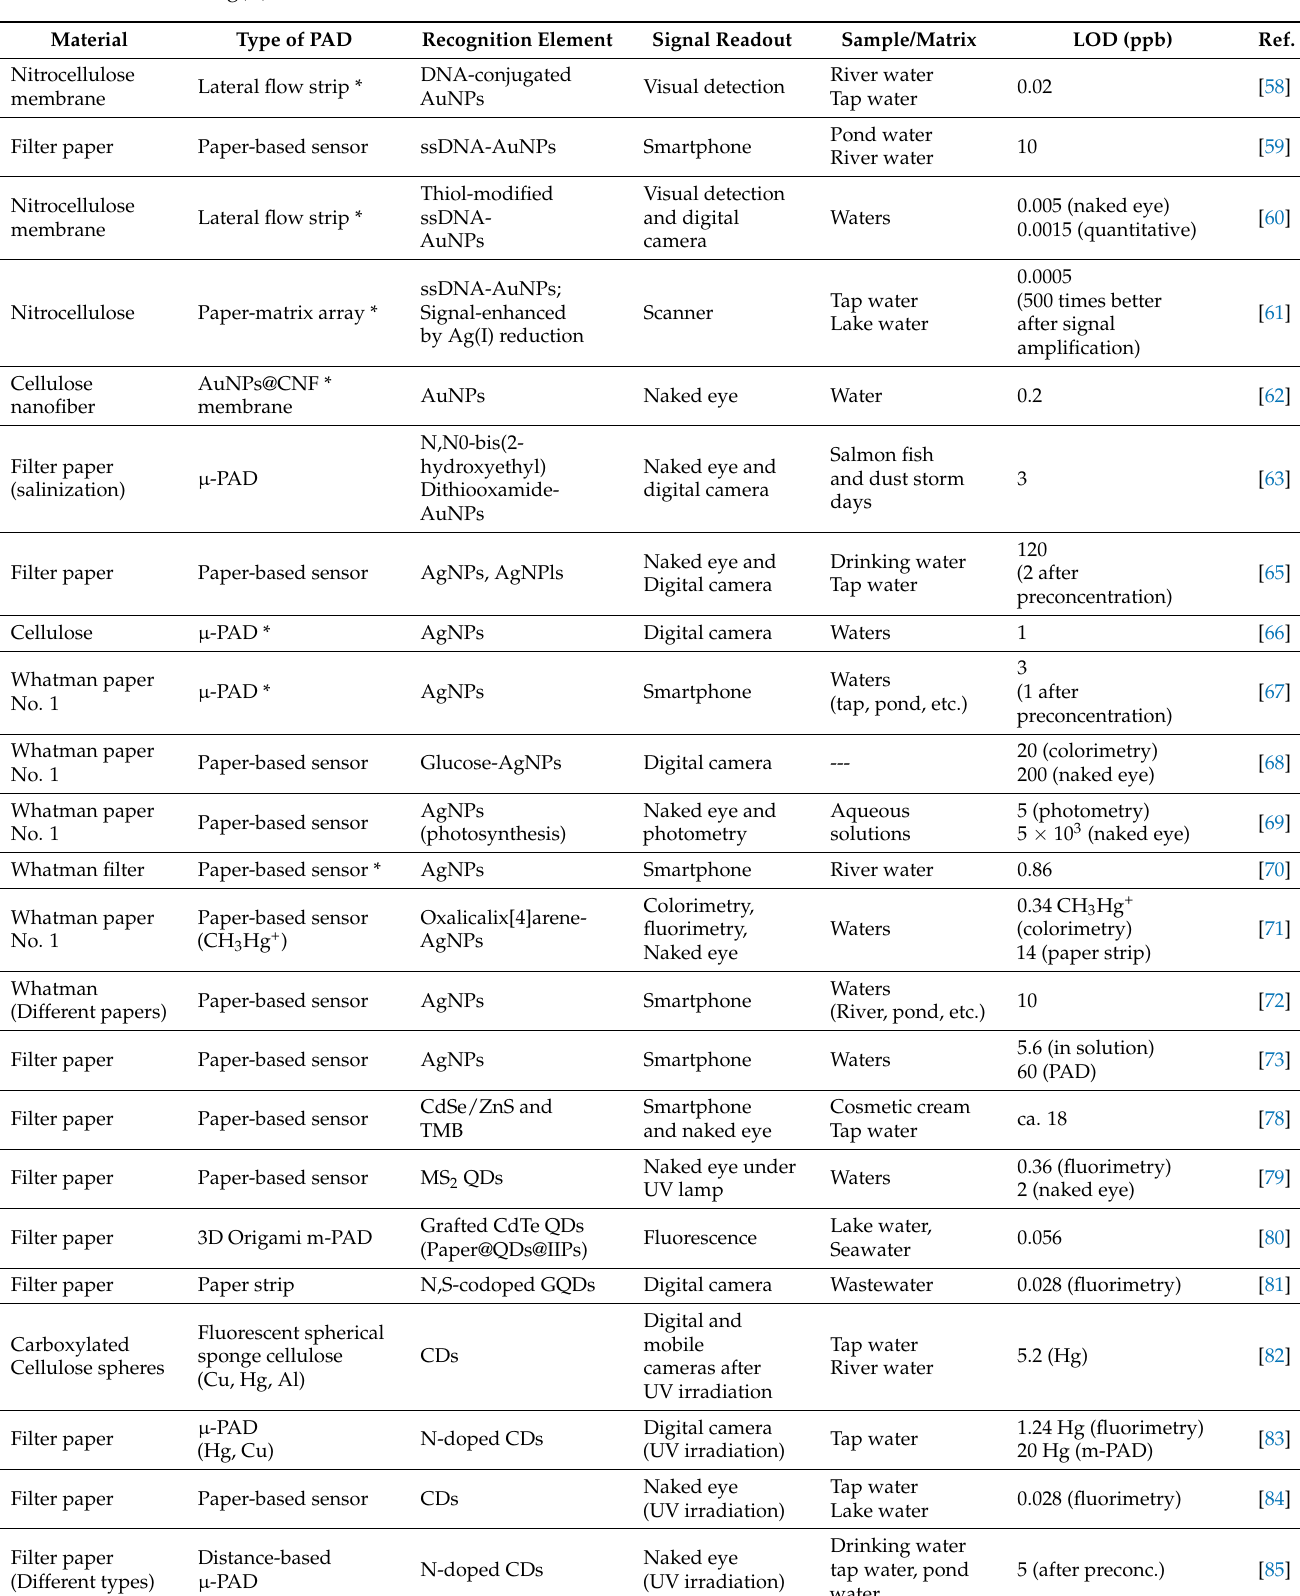
Table 2. Applications of nanomaterials as receptors in paper-based analytical devices ( µ -PADs and paper-based sensors) for the detection of